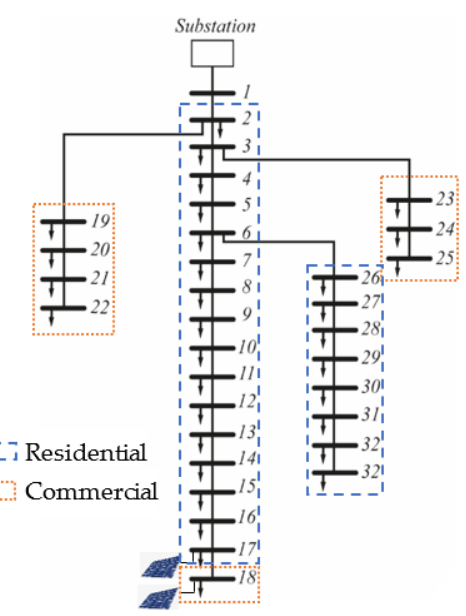
Figure 5. IEEE 33 bus test system.